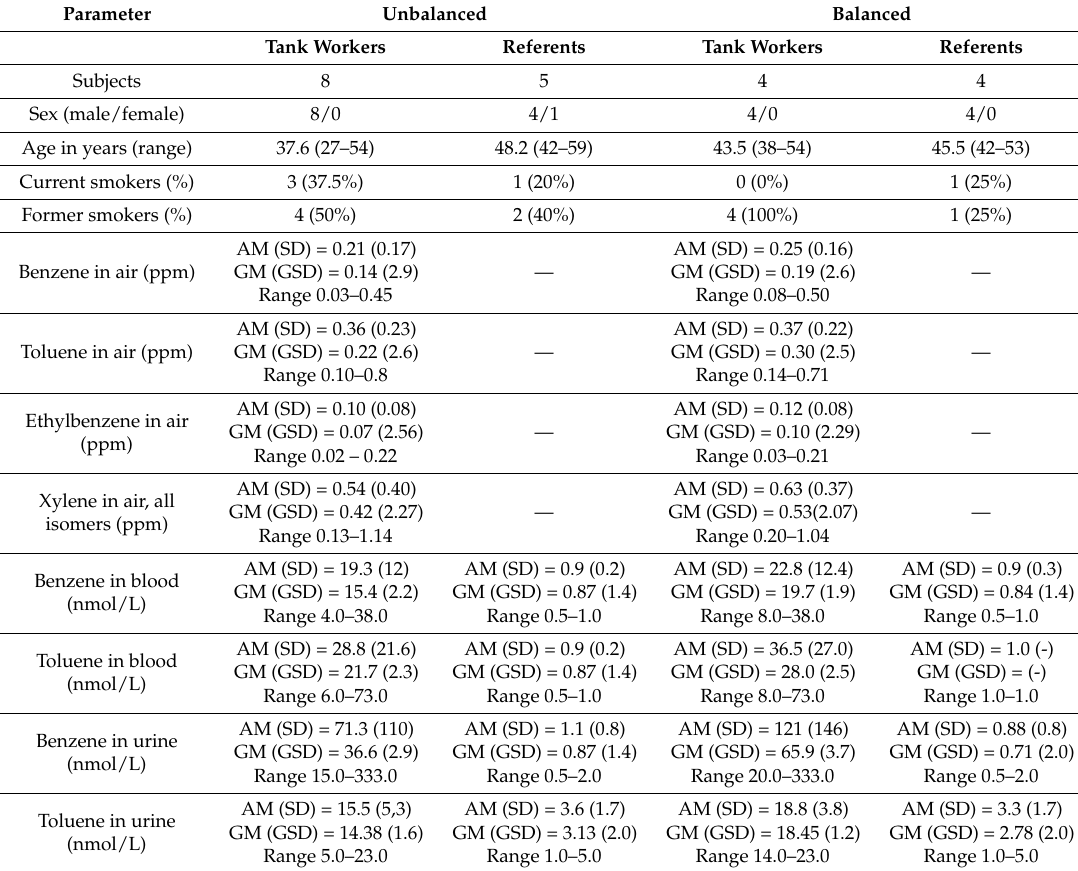
Table 1. Demographics and descriptive statistics for exposure to petroleum-derived hydrocarbons by exposure